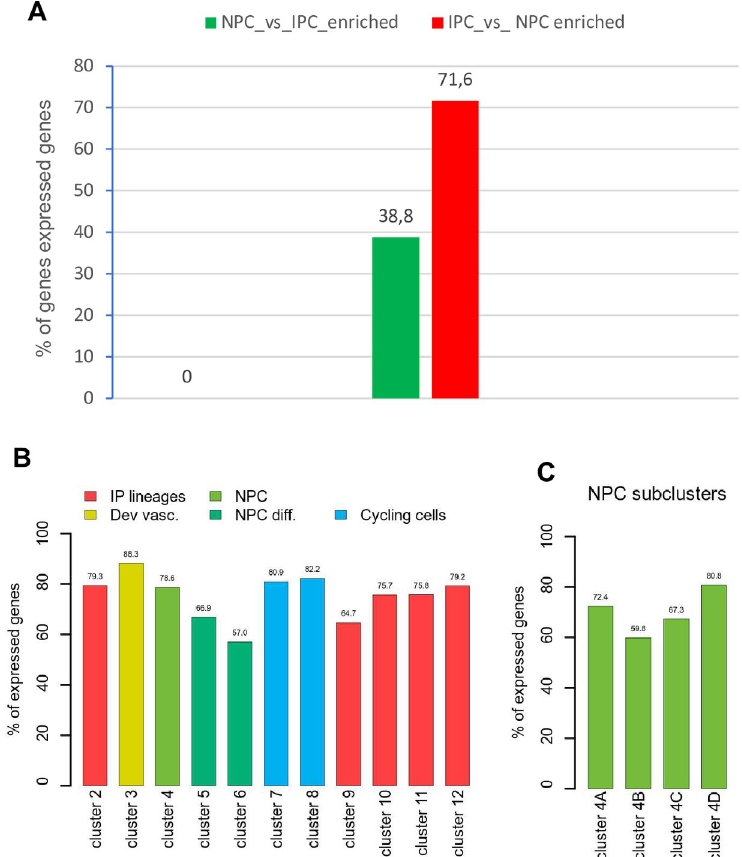
Fig 2. Analysis of genes from NPC and IPC enriched genes and from the different clusters expressed in Wilms cells [32]. A) Percent of genes from the Lindstro¨m NPC enriched (green) and IPC enriched (red) compartments expressed in Wilms cell lines ( > 1000). B) The percentage of genes expressed in each individual cluster is shown. Cluster 1, immune cells, was not analyzed. The color coding shows which clusters are part of the NP (green) or IP lineages (red). The differentiating NP cells, cluster 5 and 6 are darker green. Two clusters of cycling cells are turquois and developing vasculature cluster is yellow. C) The exclusively expressed genes in the 4 NPC subclusters and the percent of these expressed in common in the Wilms cell lines are shown, cut off >